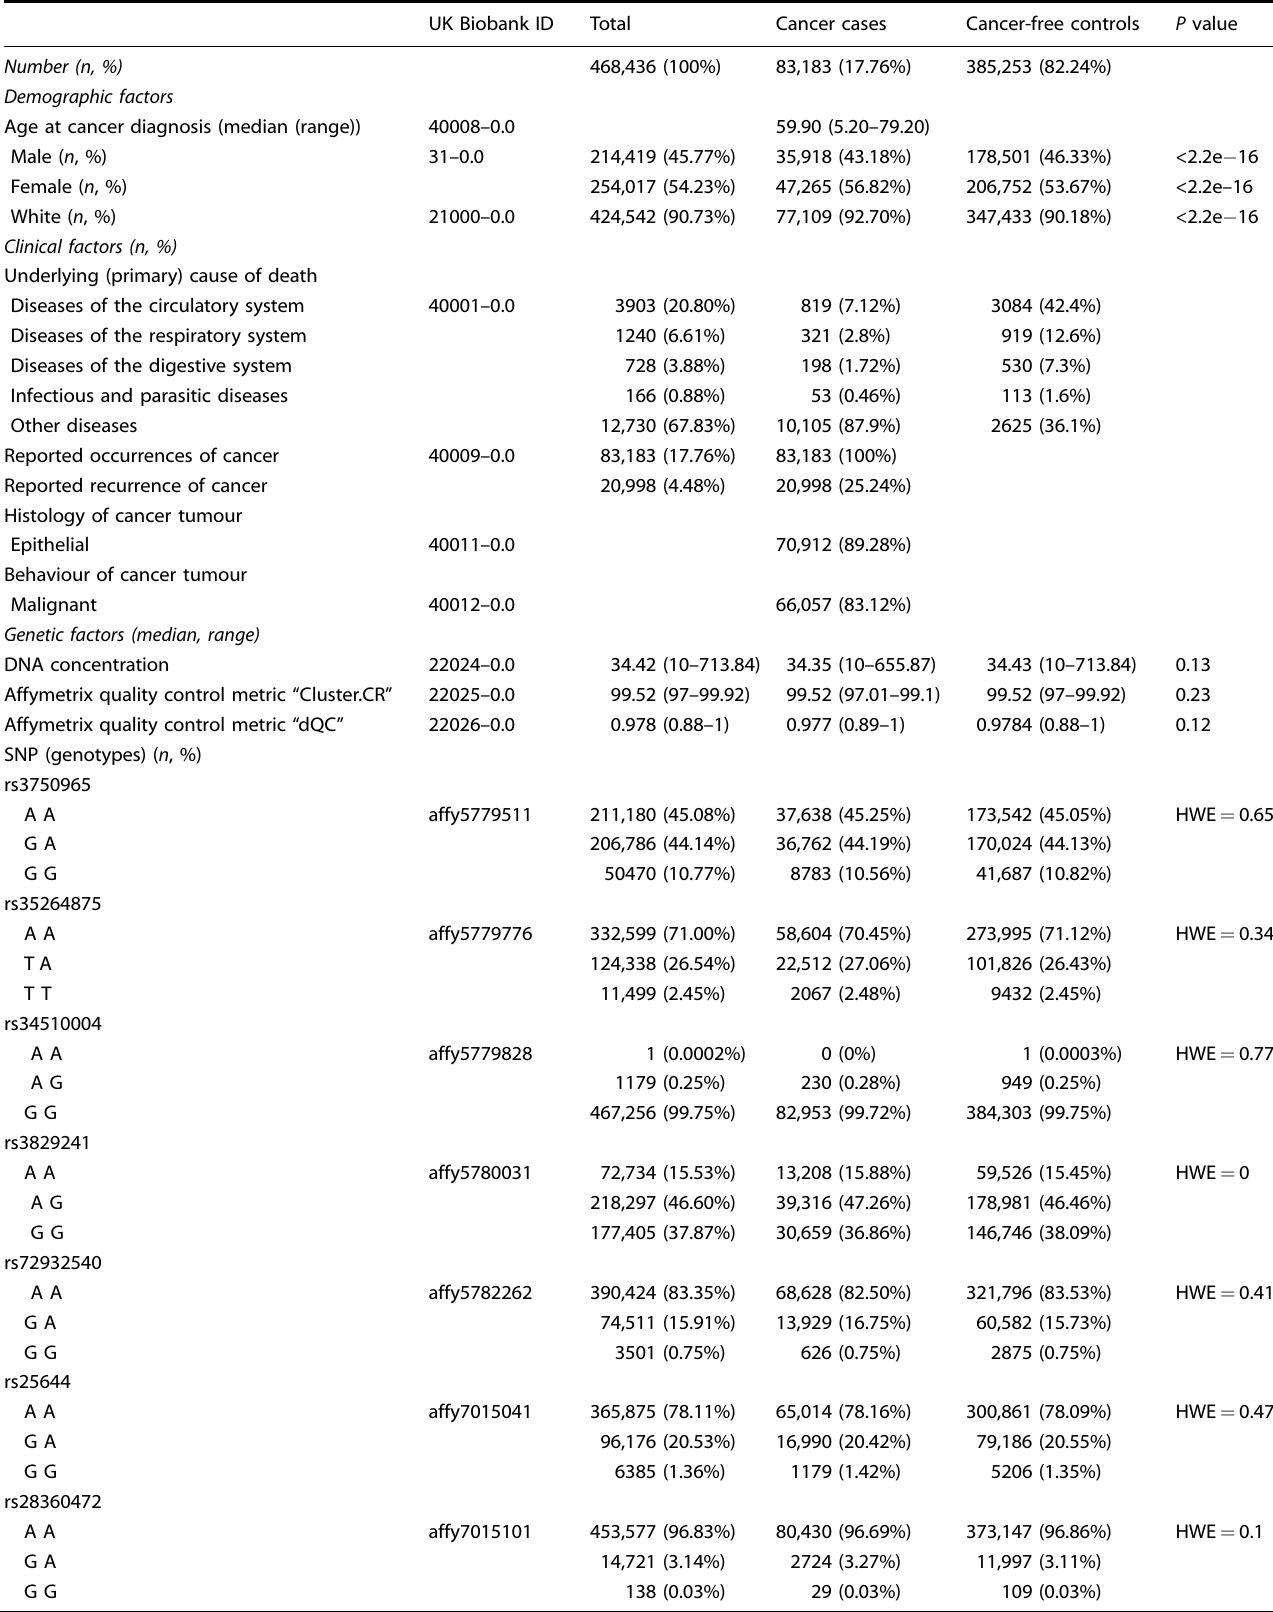
Table 1. Subject characteristics and univariate